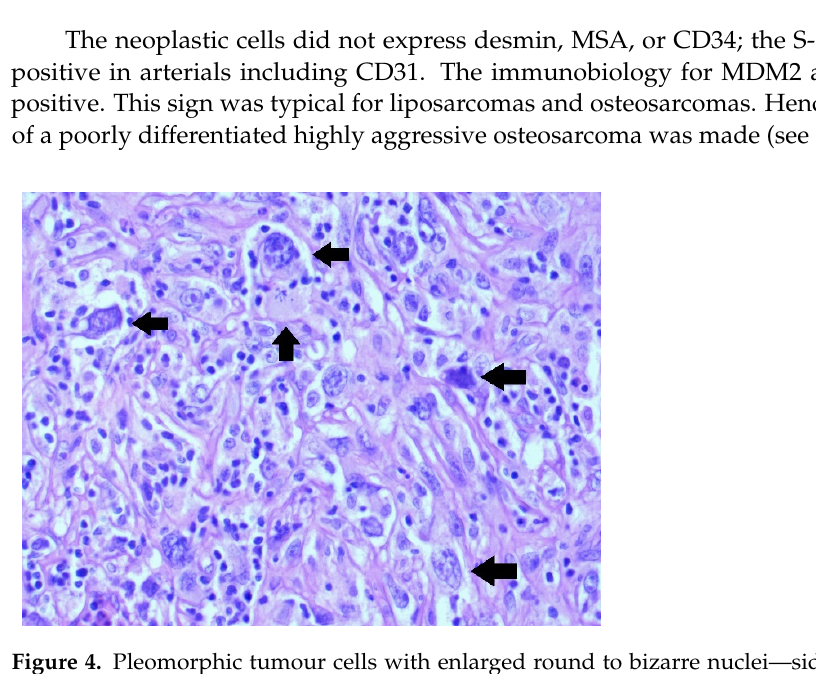
Figure 3. Highly cellular undifferentiated sarcoma in a fascicular pattern with increased mitotic activity—up arrows (H&E staining, 200 × ).